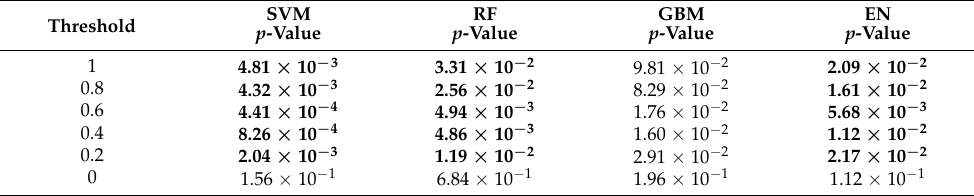
Table 1. Enrichment test of the predicted targets for HT (enrichment for targets listed in OpenTargets).